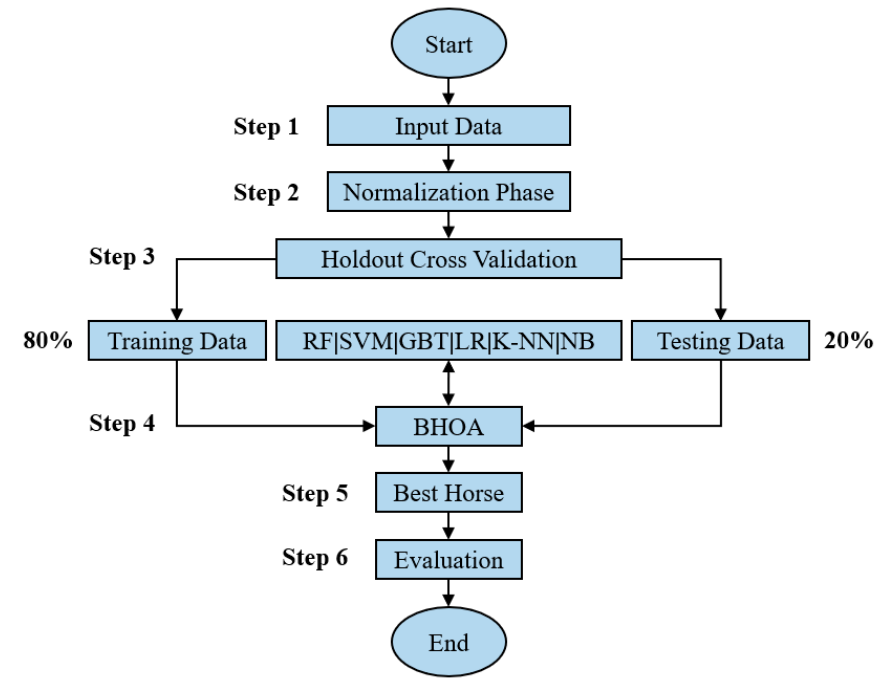
Figure 2. High-level view of the BHOA for features selection.